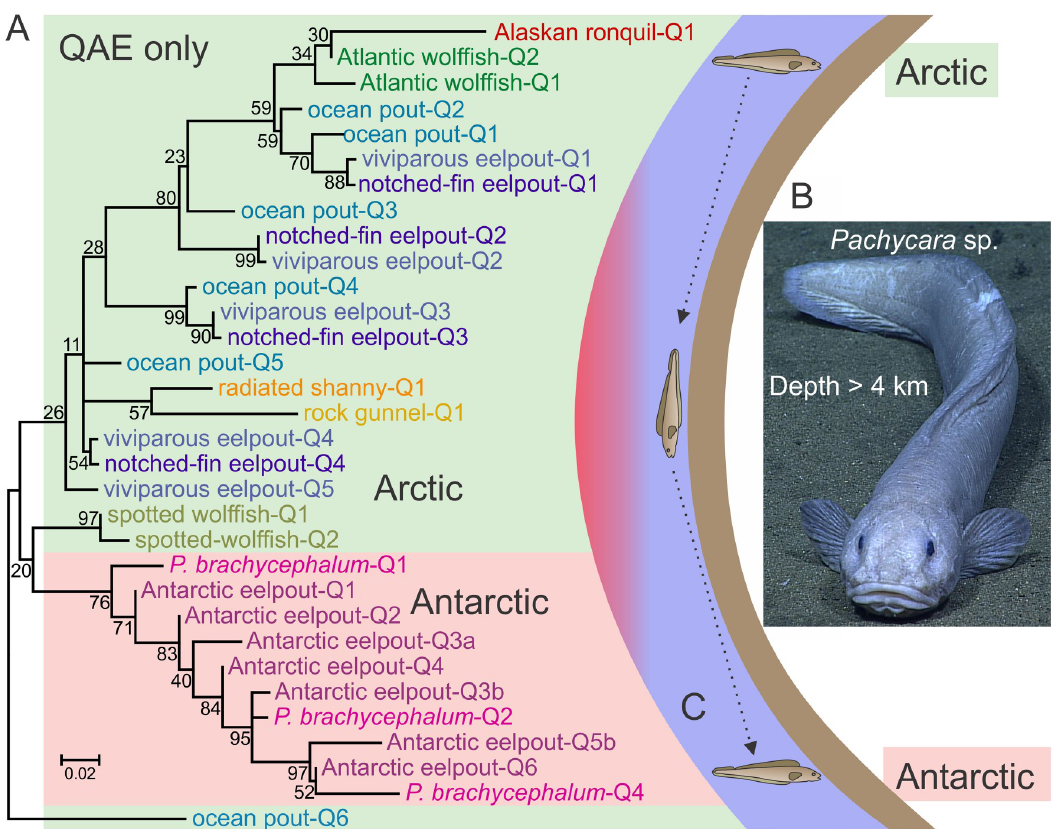
Fig 4. Phylogenetic and geographical distribution of QAE isoforms. A) Phylogenetic tree of the complete QAE subgroup from S4 Fig. Sequences are indicated as in Fig 2 and sequential tandemers from Antarctic eelpout are labelled alphabetically (e.g. Antarctic- eelpout-Q3a, Antarctic-eelpout-Q3b). Sequences from northern fish are on a green background while those from southern fish are on pink. The scale bar represents an average of 0.02 changes per site and bootstrap values (percent) are indicated at most nodes. B) A newly-discovered Pachycara sp., found during the 2016 NOAA Okeanos expedition at the Mariana Trench, 18˚27´ N; 147˚50´ E, in 1.5˚C waters below 4000 m (https://service.ncddc.noaa.gov/rdn/oer-rov-cruises/ex1605l3/#tab-20). C) Diagram of a cold-water migration route through a cross-section of the oceans from the Arctic to the Anarctic. The deep water passage shown by the dotted arrows through the tropics avoids warmer surface waters (red).